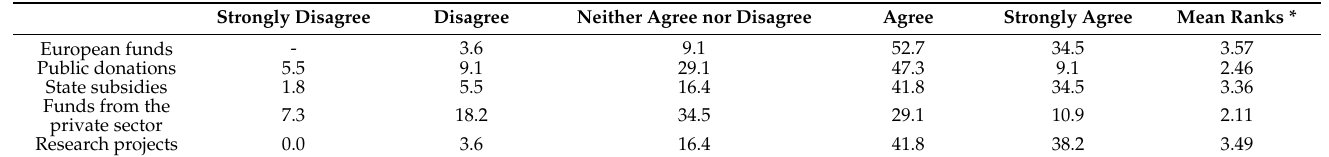
Table 3. Percentage units and differences among respondents’ rankings regarding Hub’s funding sources. Strongly